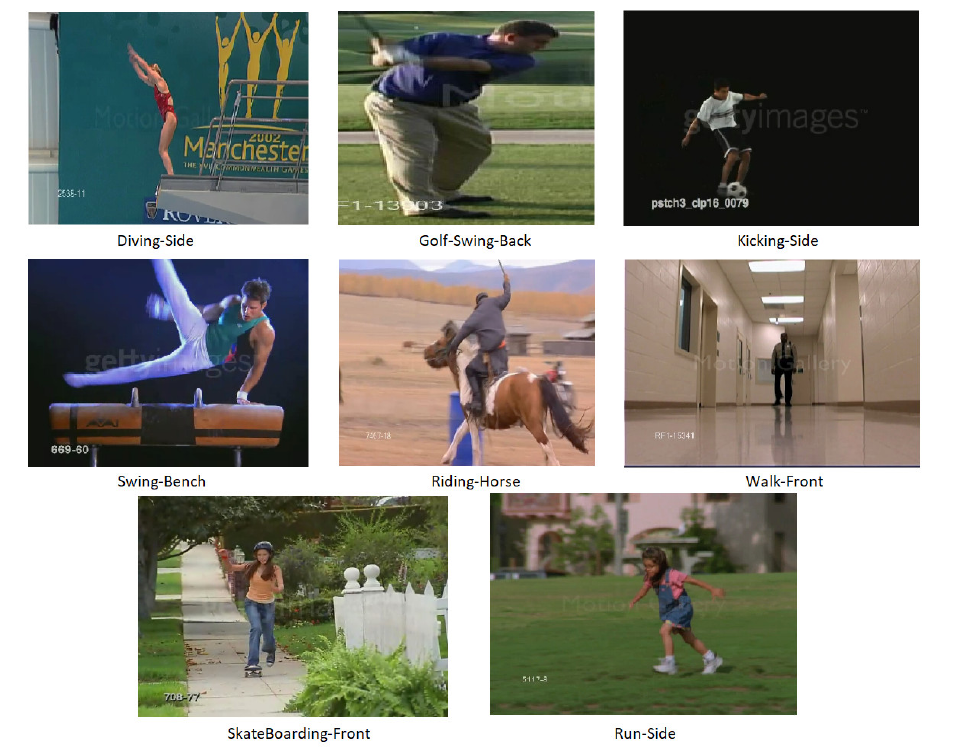
Figure 2. Snapshots of different videos from the UCF Sports dataset depicting the different types of action classes.